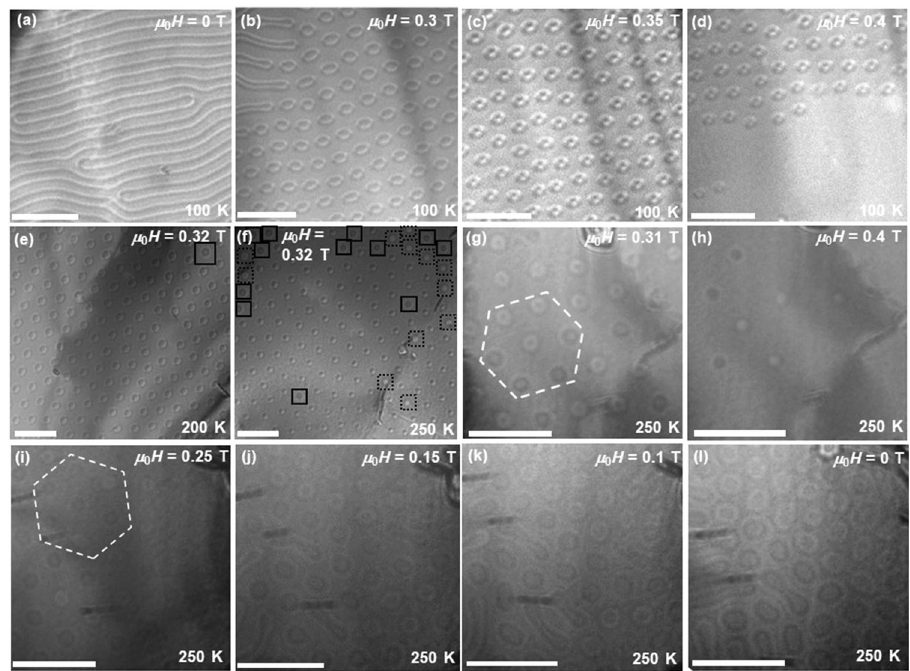
Fig. 3 Over-focused Lorentz transmission electron microscopy (LTEM) images of magnetic textures evolved with magnetic fi elds and temperatures for Mn 4 Ga 2 Sn. a – d LTEM images of the magnetic states recorded with increasing external magnetic fi eld from 0 T to 0.4 T at 100 K. e , f LTEM images of the magnetic domain evolution at magnetic fi eld 0.32 T for temperatures 200 K and 250 K. The solid and dotted boxes represent skyrmionic textures with two different helicities. All the images in ( a – f ) are taken at nearly 4 degrees of sample tilting condition. g – l The fi eld evolution of magnetic skyrmions at 250 K taken with increasing and decreasing the out-of-plane magnetic fi eld at nearly zero tilting condition. The hexagonal skyrmion lattices are marked with the dotted hexagon in ( g , i ). The scale bar shown in the images corresponds to 500 nm. H corresponds to the magnetic fi eld and μ 0 is the permeability of